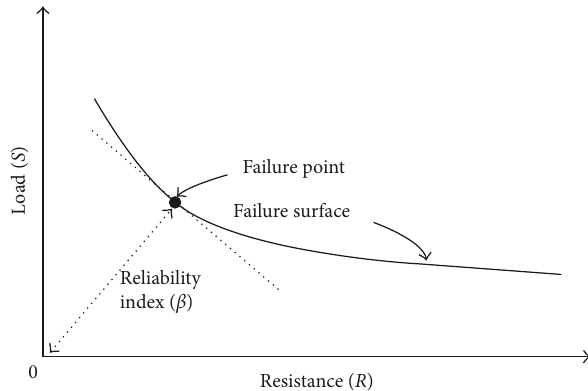
Figure 2: Reliability index as a function of load and